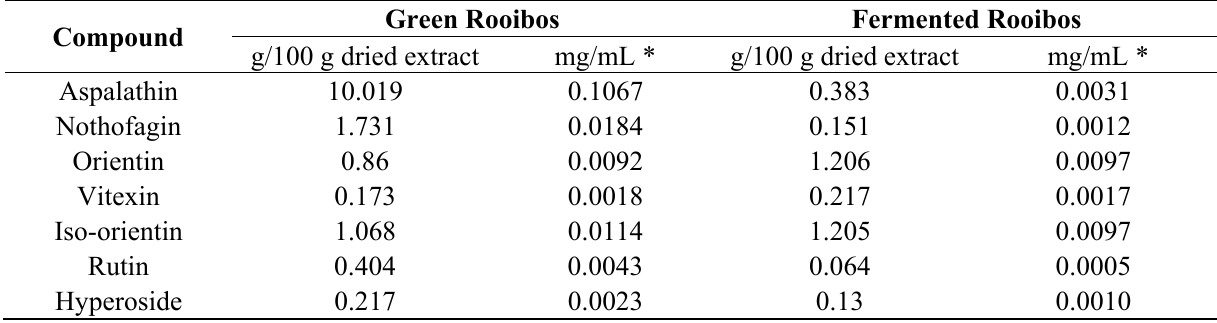
Table 2. Polyphenolic composition of green and fermented rooibos infusions. Content is expressed in g/100 g of dried infusion or as mg/mL infusion of each compound.